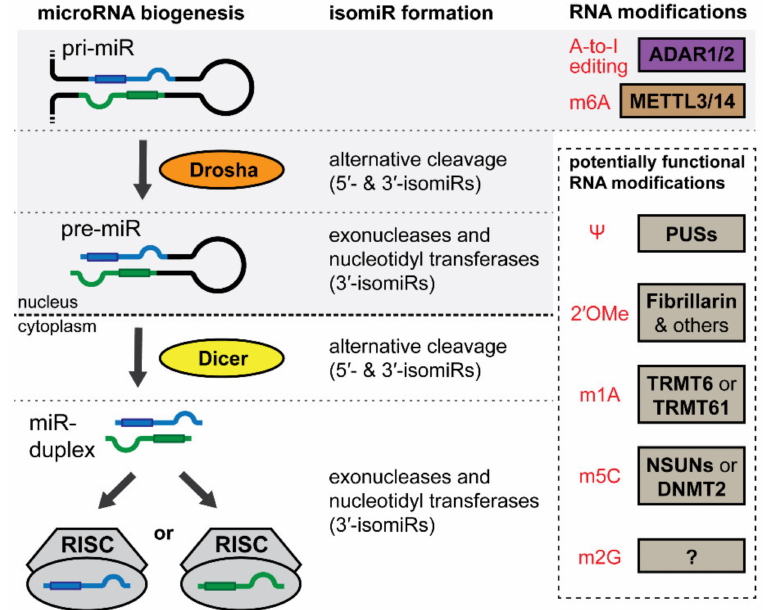
Figure 1. MicroRNA biogenesis and alterations that induce isomiR formation or microRNA nucleotide modifications. Transcription of the microRNA containing gene forms the primary microRNA (pri-miR). Drosha cleaves the pri-miR to generate the precursor microRNA (pre-miR). The pre-miR cleaved by Dicer in the cytoplasm yielding the microRNA duplex. Either side of the duplex can be incorporated into the RNA-induced silencing complex (RISC) to become a functional mature microRNA. IsomiRs can be formed during microRNA biogenesis when Drosha or Dicer cleave in alternative locations, or when exonucleases or nucleotidyl transferases remove or add nucleotides to the 3 (cid:48) -end of the pre-miR or the mature microRNA. RNA nucleotide modifications with known or potential functional implications on microRNA biogenesis or functioning are shown in red with their ‘writers’ next to